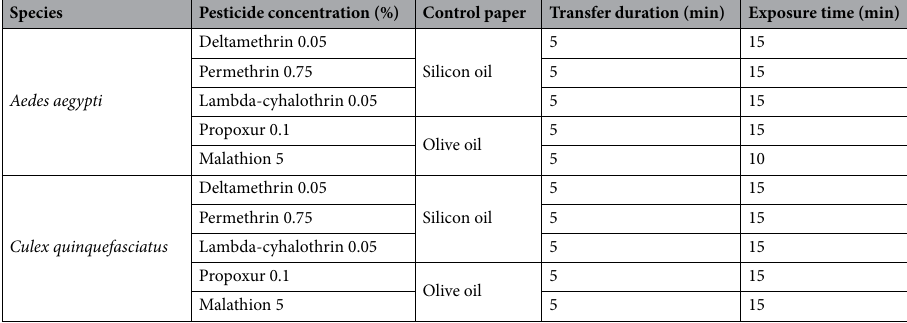
Table 3. Optimised pesticide concentration and duration of transfer used in preparing for sub-lethal mosquito conditioning exposure using WHO tube tests (see Methods for